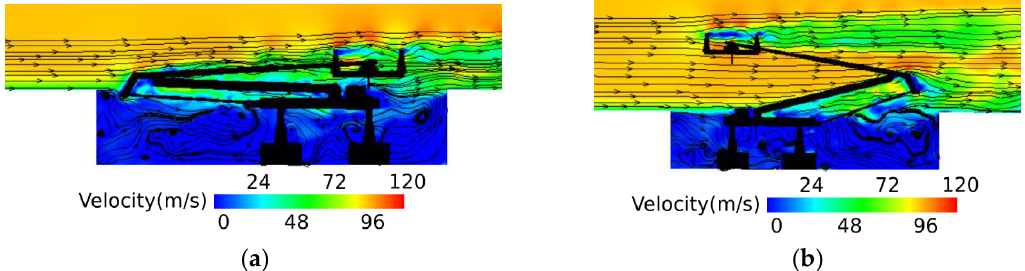
Figure 14. Streamlines superimposed on color iso-levels of the time-averaged velocity vector magnitude: ( a ) down-pantograph with sunken base; and ( b ) up-pantograph with sunken base.